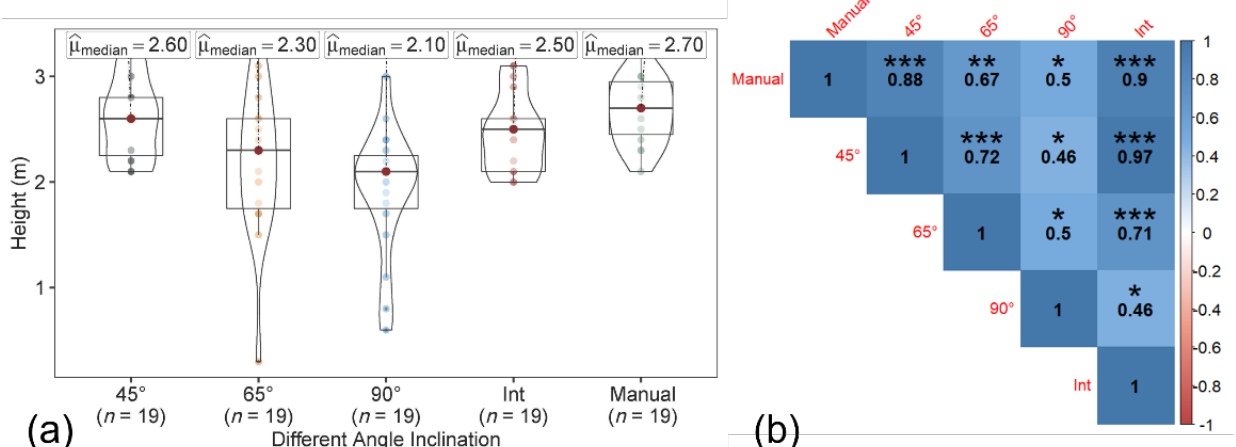
Figure 5. Canopy height model generated using the T1 (Pix4D) and T2 (point sampling) ap- proaches.